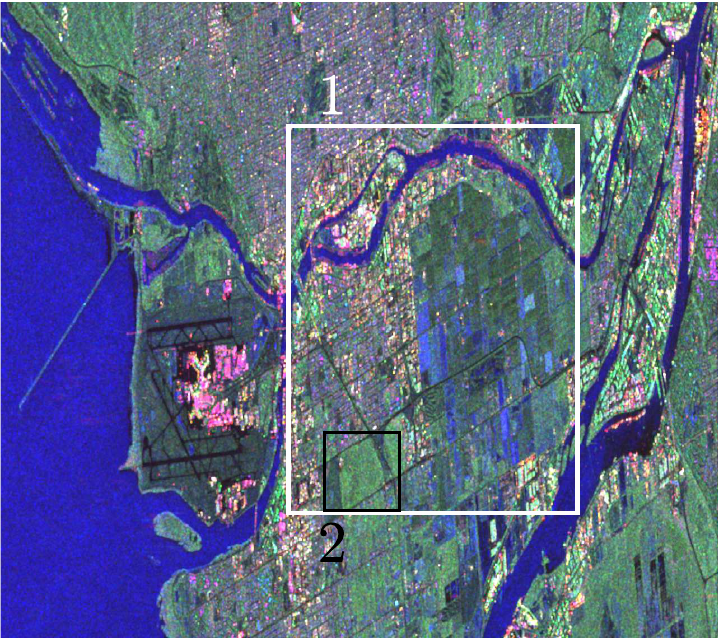
Figure 8. Pauli RGB, 25-look, of a portion of the Radarsat-2 Vancouver sample dataset, highlighting two specific subsets, (1 and 2), analyzed in the